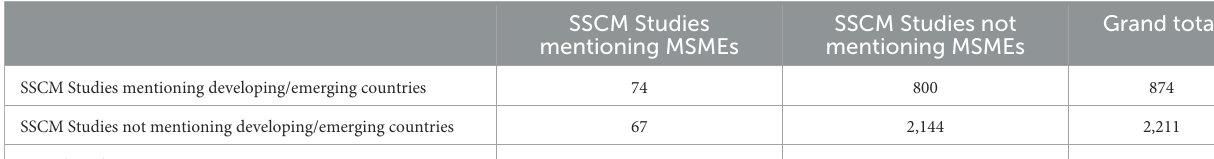
TABLE 7 Frequency of SSCM studies by MSMEs and developing/emerging economies.